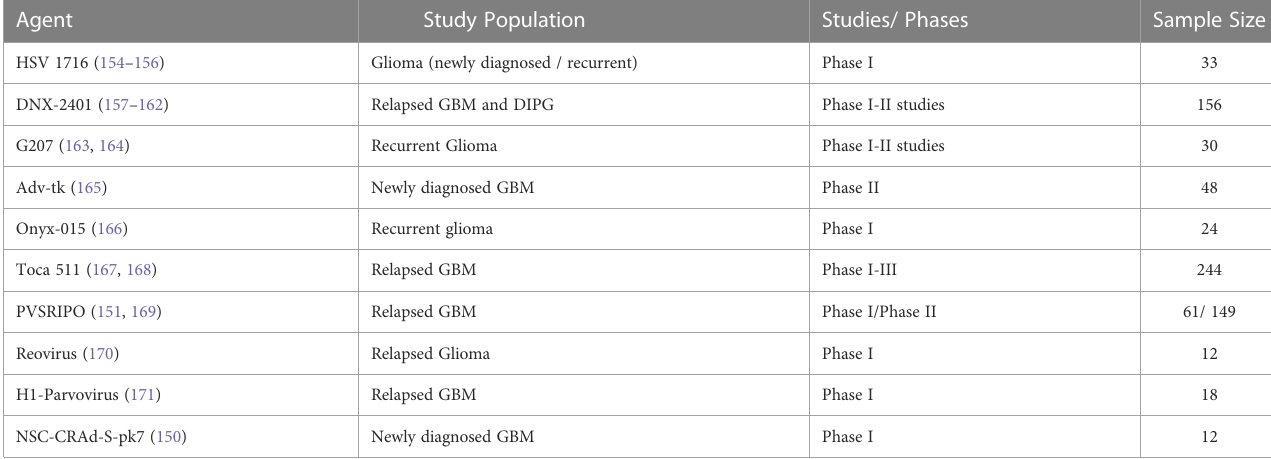
TABLE 5 Completed and Published Oncolytic Virus Trials for Primary Brain